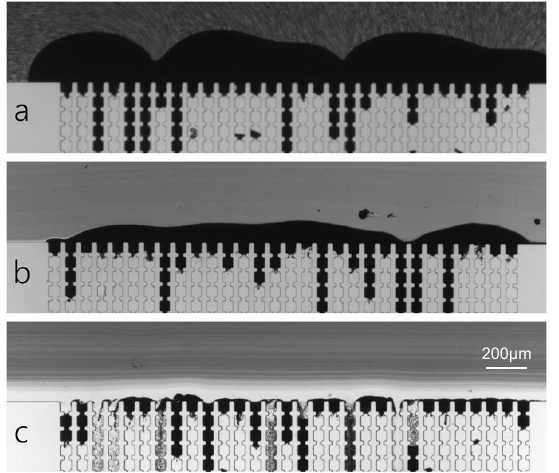
Figure 12. Cake layer formation during ( a ) dead-end and crossflow filtration at 0.219 mL/min and 0.395 mL/min ( b , c ). Figures clearly show how particle deposition is influenced by the filtration mode. Black regions indicate the presence of a higher particle concentration. Adapted from [100].